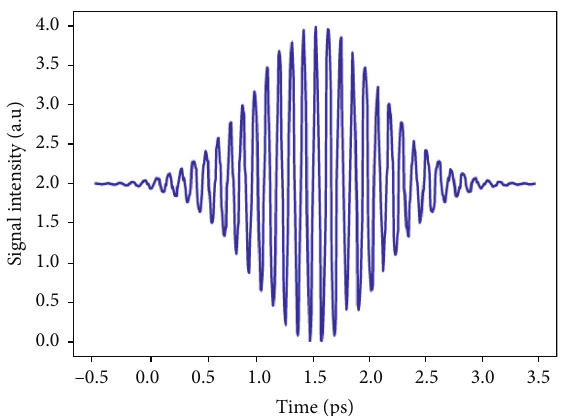
Figure 5: Signal intensity of the broadband coherent